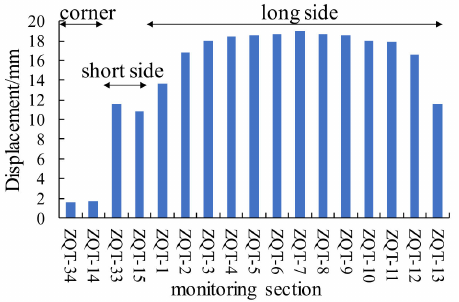
Figure 6. Maximum horizontal displacement of